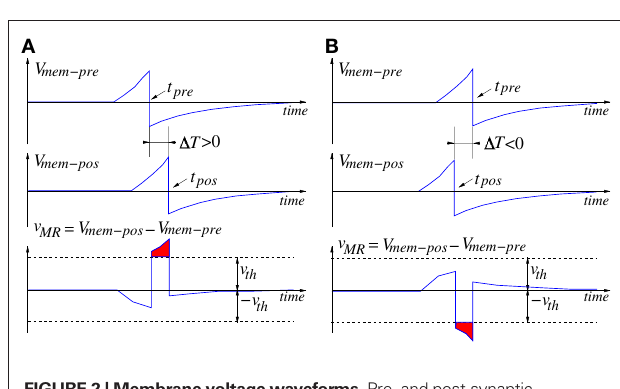
Figure 2 | Membrane voltage waveforms. Pre- and post-synaptic membrane voltages for the situations of positive ∆ T (A) and negative ∆ T (B) . Voltage v is the difference between the post-synaptic membrane voltage MR V and the pre-synaptic membrane voltage V mem − pos